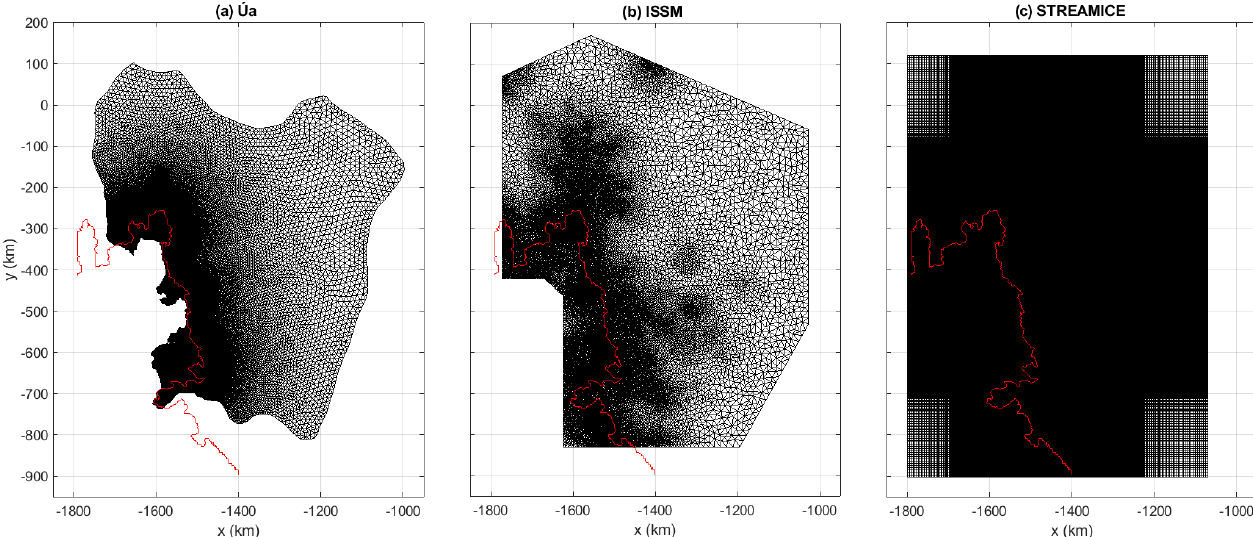
Figure 2. The meshes used by each model for the inversions. All domains cover our area of interest, including Thwaites and Pine Island glaciers and the Dotson and Crosson ice shelves. The main grounding line is shown in